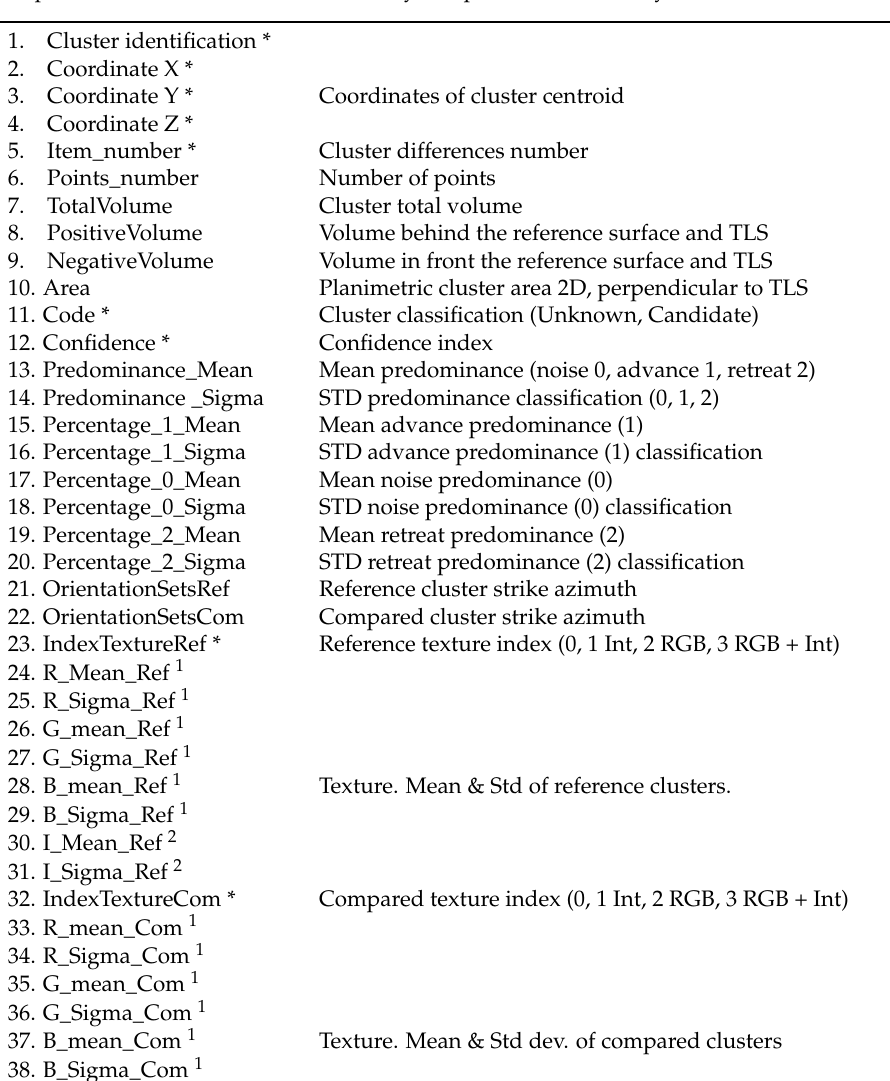
Table A3. Features associated to the Clusters, format order. * No used in ML classification. 1 Only computer with RGB format is used. 2 Only computed with Intensity format is